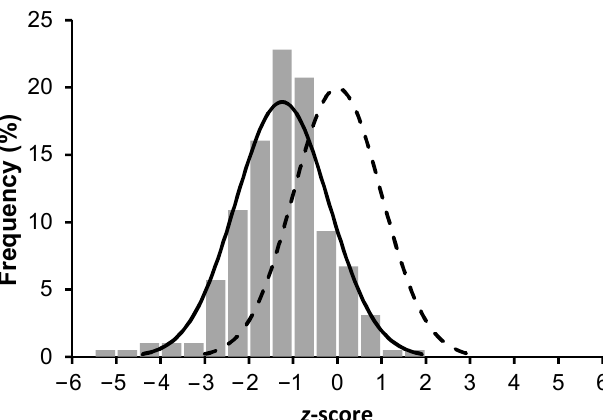
Figure 1. BMI-for-age z -score distribution in children aged 7–12 years ( n = 193) in Burkina Faso. The normal distribution curves are given for these children (solid line, mean = − 1.24 ± 1.05) compared with the WHO child growth standards for children 61 months–19 years of age (dashed line, mean = 0 ± 1).